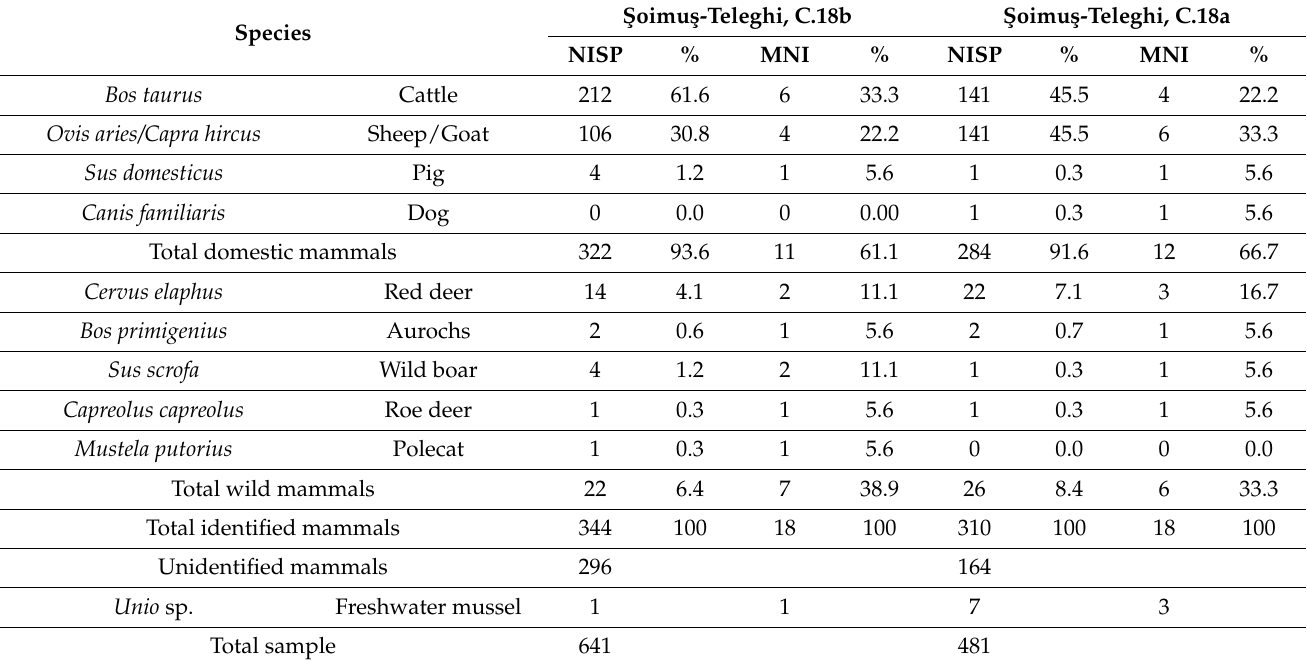
Table 4. Quantification of archaeozoological samples (NISP = number of identified specimens; MNI = minimum number of individuals).